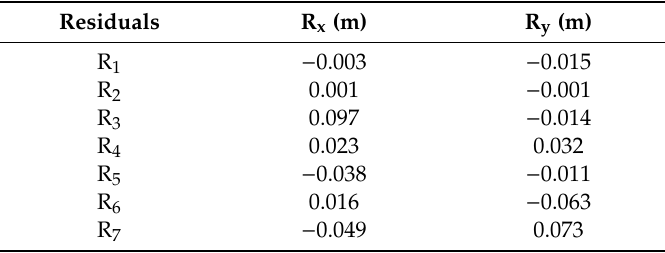
Table A8. Residual values of bilinear